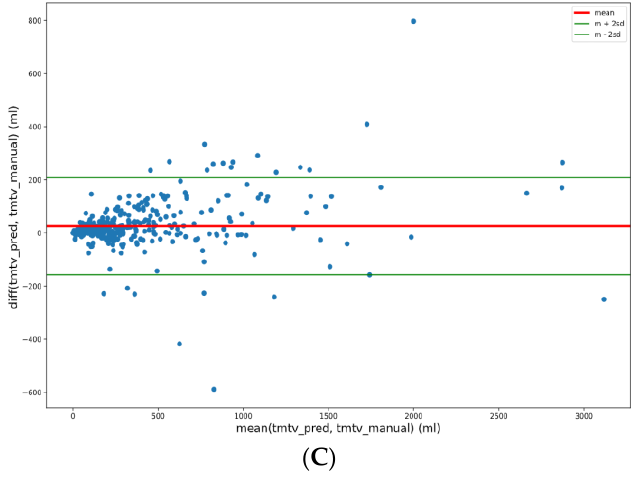
Figure 2. Bland – Altman plots between manual and predicted TMTV for each methodology ( A ) 41%, ( B ) 2.5, ( C ) 4.0. The Spearman correlation coefficients with manual TMTV for 41%, 2.5 and 4 cutoffs were r = 0.92, 0.95 and 0.98, respectively, with p < 0.001 for each methodology. (Figure 3)